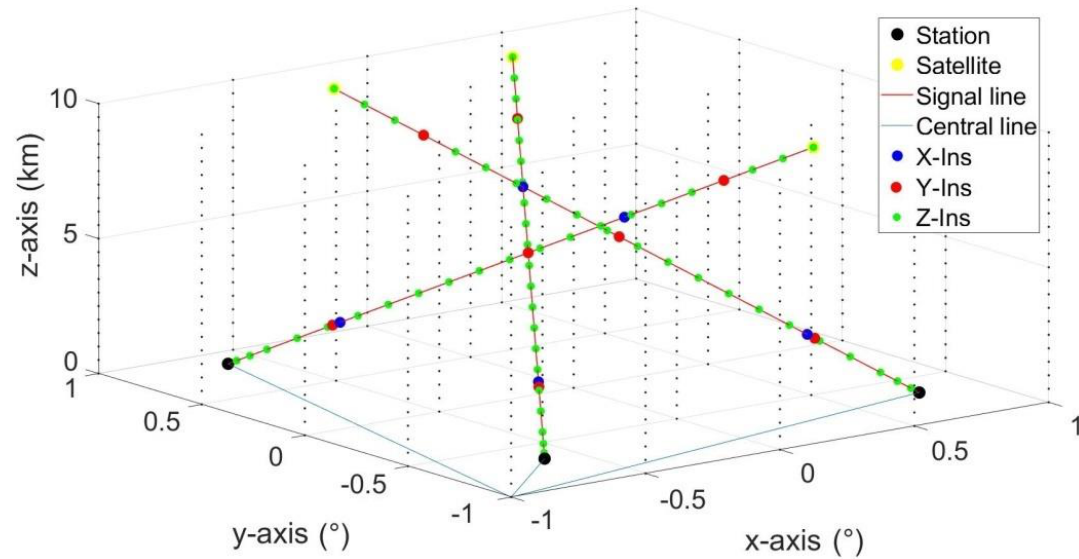
Figure 3. The intersections of signal lines and the model (black and yellow balls are the positions of the station and satellite; blue, red, and green balls are the intersections of the signal lines and the model; red and blue lines are the signal and central lines).